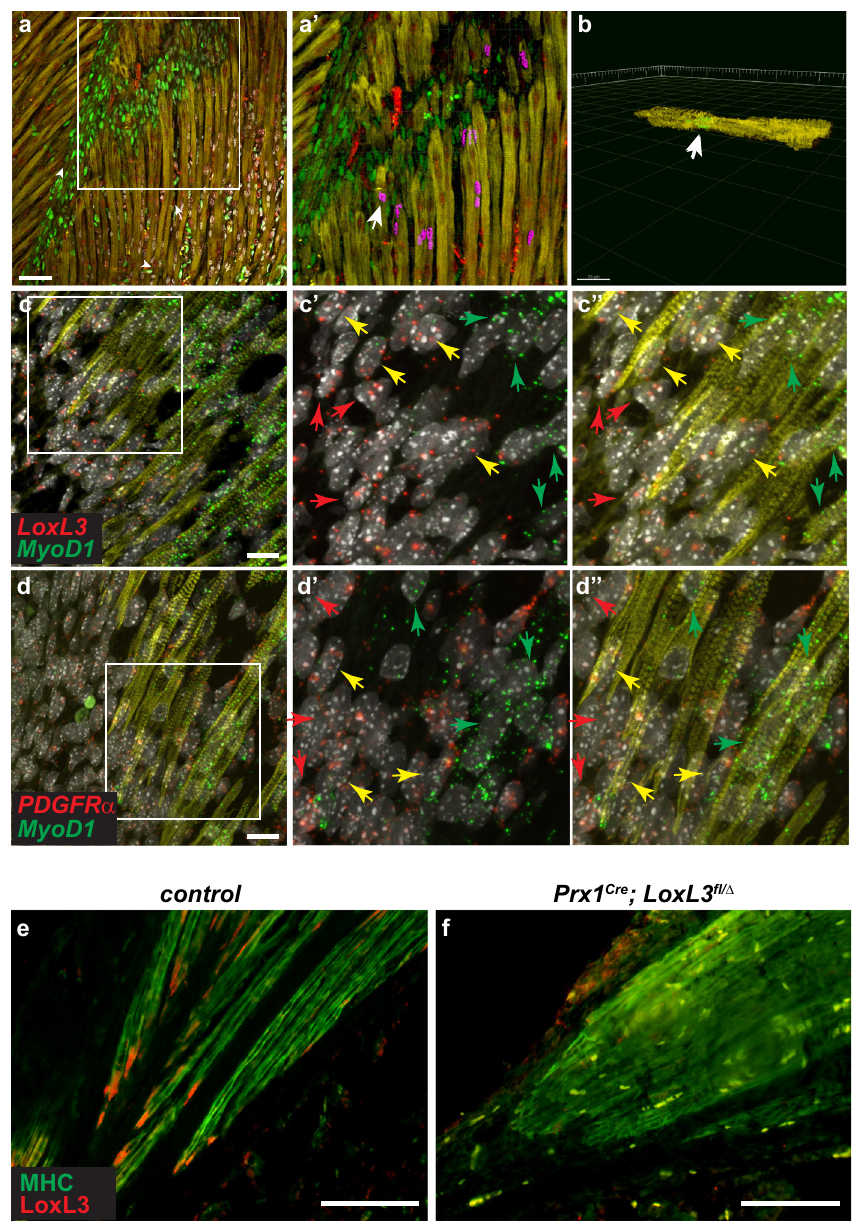
Fig. 5 LPM-derived cells fuse into myo fi bers along the MTJ. P0 Prx1 Cre ; Rosa nt-ng limbs were subjected to immunostaining for MHC (yellow), EGFP (green) and tdTomato (red) ( a ) followed by IMARIS analysis demonstrates LPM-derived cells fuse into fi bers at the proximity of the MTJ ( a ′ purple; b lateral view of fi ber section marked by white arrow in a ′ ) ( a , b ). FISH for LoxL3 and MyoD1 ( c-c ″ ) or PDGFR α and MyoD1 ( d-d ″ ) on E15.5 limb sections. Tagged images show magni fi cation of boxed areas in c , d . Staining demonstrates spatial localization of the distinct nuclei at the fi ber tips those located towards the center of the muscle express only MyoD1 (green arrows in c ′ , d ′ ), those closer to the tips (but also outside) express MyoD1 and fi broblastic markers (yellow arrows in c ′ , d ′ ) and those outside of the fi ber towards the tendon express only fi broblastic markers (red arrows in c ′ , d ′ ). Immunostaining for MHC (green) and LoxL3 (red) on E17.5 control ( e ) and Prx1 Cre LoxL3 fl / Δ ( f ) demonstrates LoxL3 is missing at myo fi ber tips following its deletion in fi broblasts. IMARIS analyses ( a – b ), immunostaining and FISH results ( c – f ) are representative results derived from at least three independent embryos from distinct litters of the speci fi c genotypes. Scale bar in a , e , f = 50 µ m, in b = 15 µ m and in c , d = 10 µ